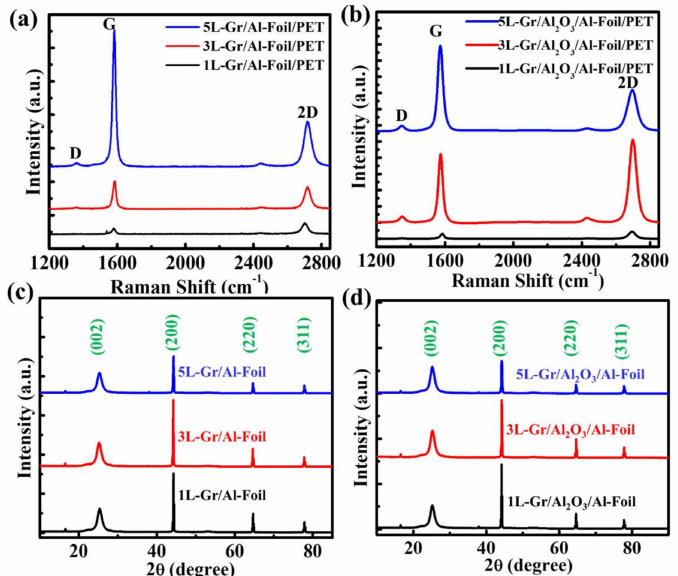
Figure 2. The Raman spectra of ( a ) graphene/Al-foil/PET and ( b ) graphene/Al 2 O 3 /Al-foil/PET. XRD patterns of ( c ) graphene/Al-foil/PET and ( d ) graphene/Al 2 O 3